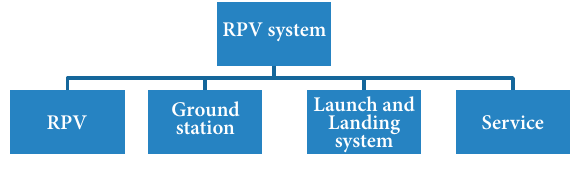
Fig. 1. Parts of an RPV system RPV. There are different types and shapes of RPVs.